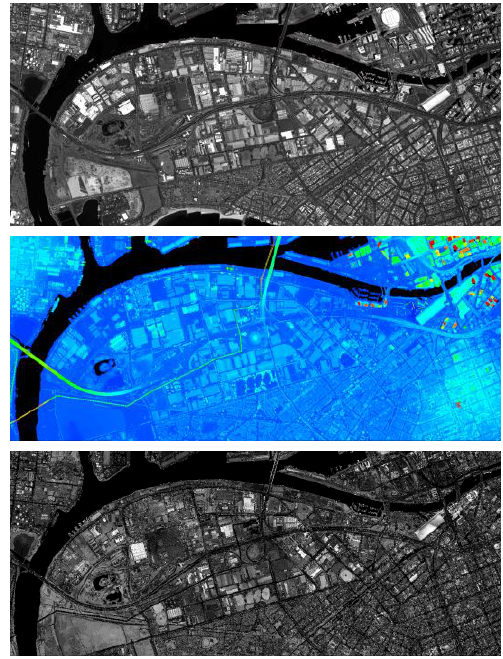
Figure 5. Registered WorldView2 image (green) with LiDAR (magenta) DSM and intensity image (left and right).